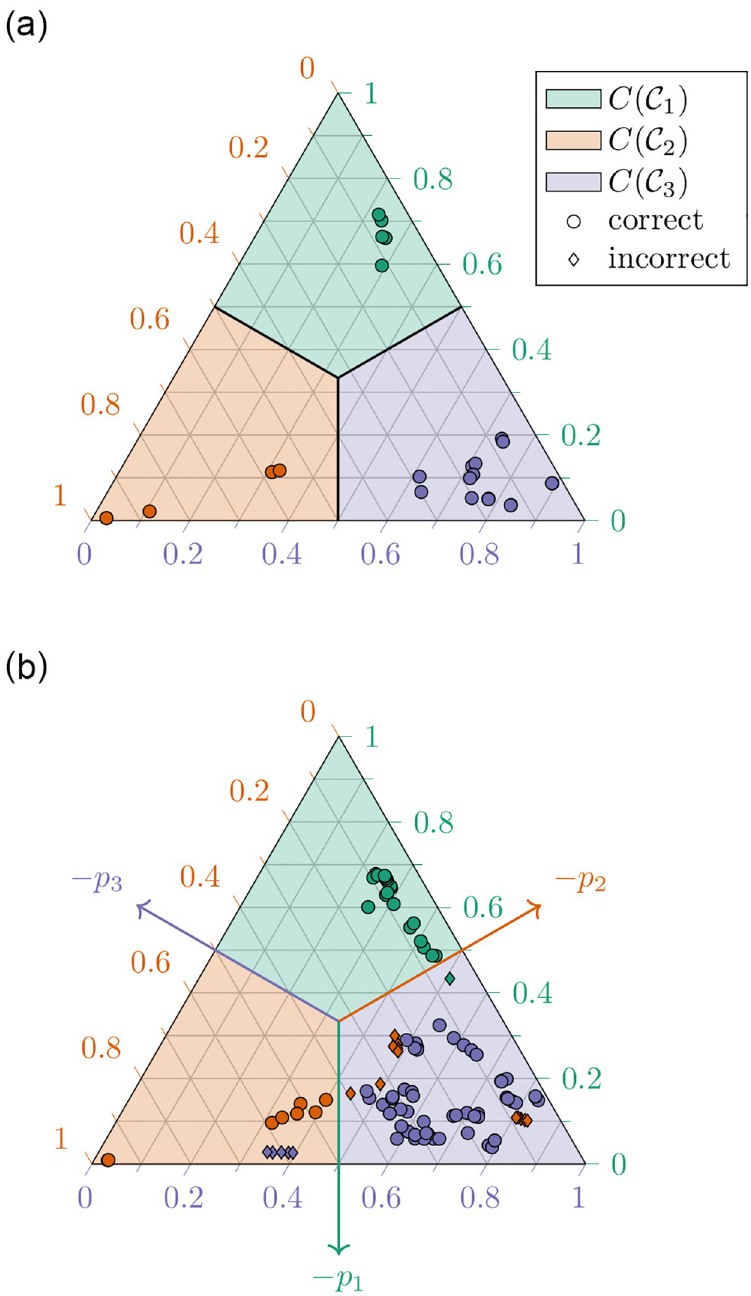
Fig 9. Compressed latent space representation. (a) Compressed latent space representation of the training data. (b) Compressed latent space representation of the test data. Images of (a) the training datapoints under the transformation C � f and of (b) the test datapoints under the transformation C � ^ f . See (46) and (47), respectively. The color of each point represents its true class, while the form of the markers indicates whether a point is correctly classified ( � ) or not ( ♢ ) by our CASIMAC. All training datapoints are correctly classified by our construction of f and C , see (21) and (39). The scales on the three simplex edges indicate the barycentric coordinates of the simplex points (Lemma 14).